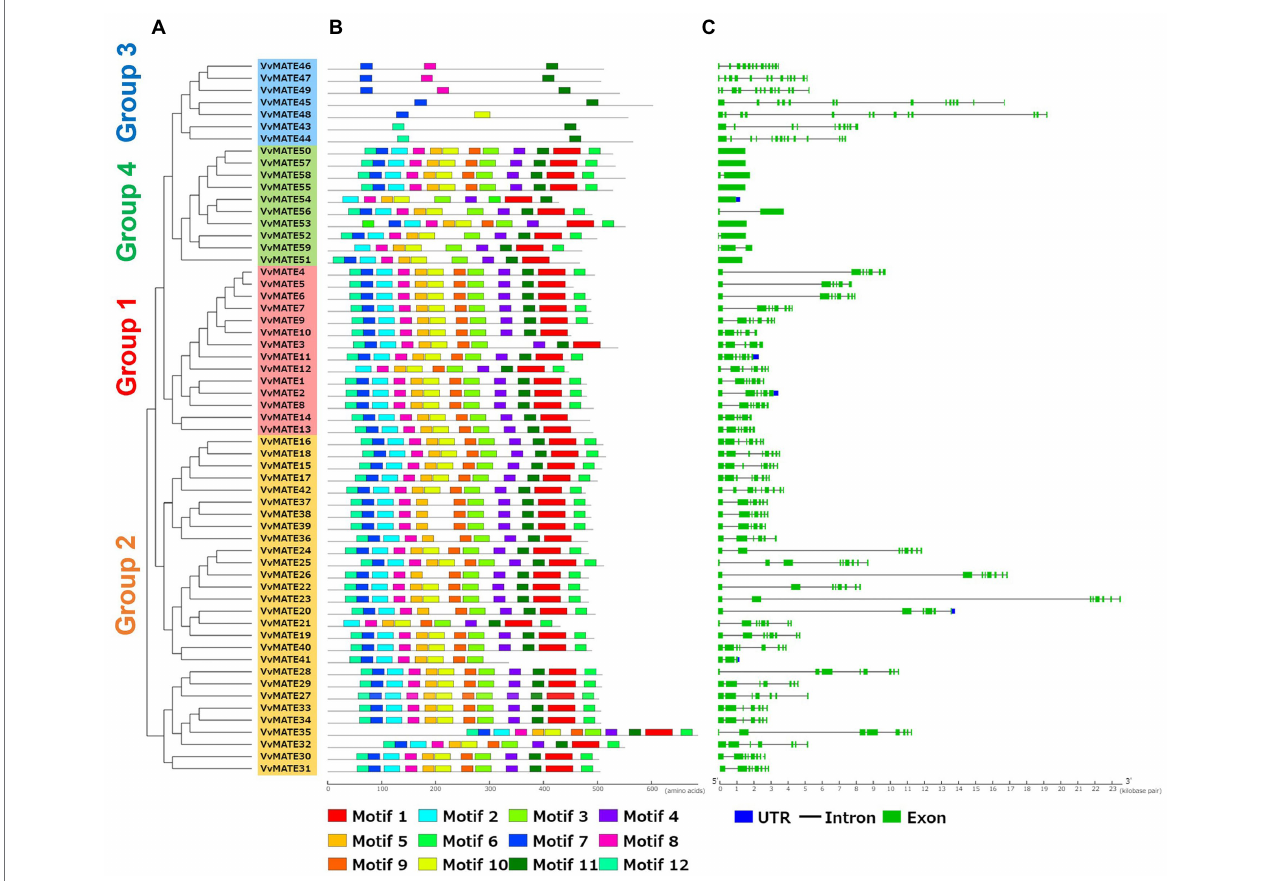
FIGURE 2 | Conserved protein motifs and gene structures of the grape MATEs. (A) The neighbor-joining tree of Grape MATEs. (B) Protein motifs of the grape MATEs. Conserved motifs were identified by the MEME web server. Different motifs are represented by different colored boxes. (C) Exon–intron structures of the grape MATEs. Exons are shown as green boxes, introns are shown as black lines and untranslated regions (UTRs) are shown as blue